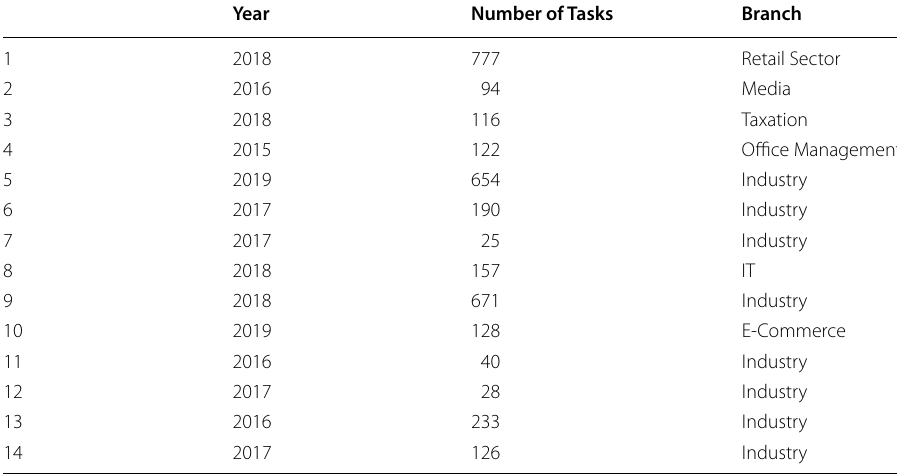
Textbooks 1 and 5 are well-established in vocational education and training, and are published in their 15 th and 48th editions,